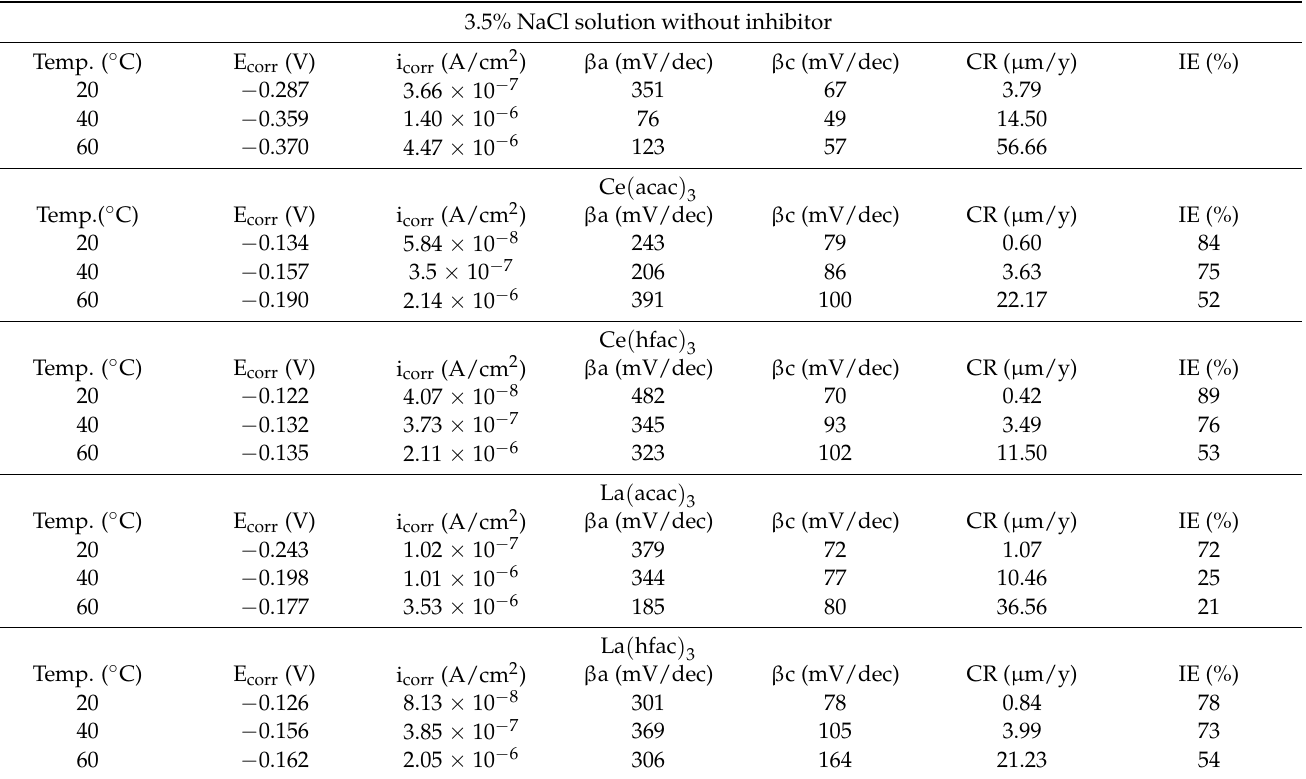
Table 4. Electrochemical parameters of 304 SS obtained from the potentiodynamic polarization curves.